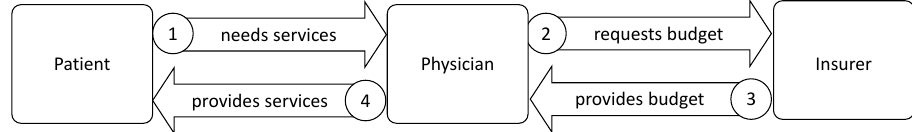
Figure 1. Relationship between the group